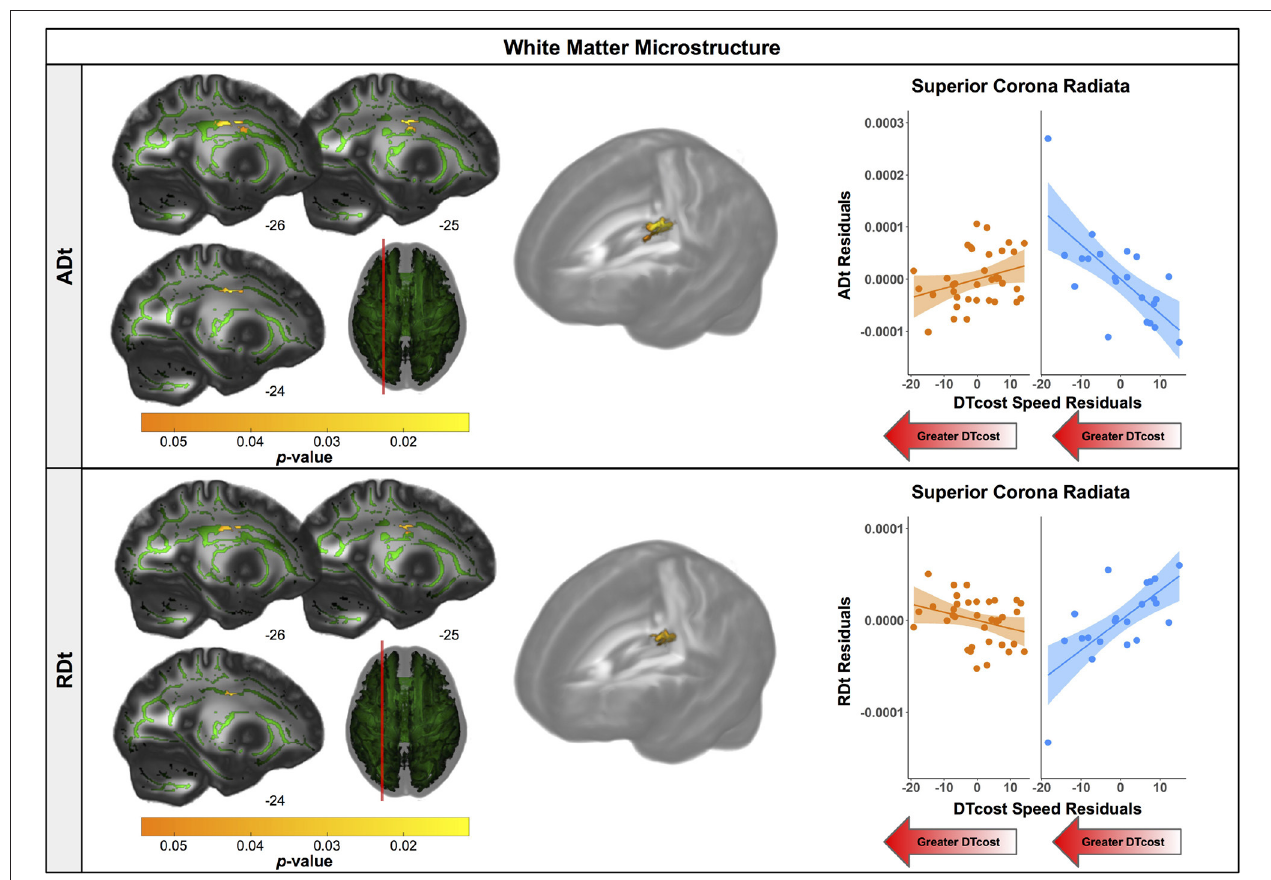
FIGURE 7 | Age differences in the relationship of FW-corrected white matter microstructure with the DTcost of gait speed. Left. Regions showing statistically significant ( p FWE − corr < 0.05) age group differences in the relationship of ADt (top) and RDt (bottom) with the DTcost of gait speed. Warmer colors indicate regions of greater age differences. Results are shown on the FMRIB58 FA template with the group mean white matter skeleton (green) overlaid. Right. ADt and RDt values for the peak result coordinate for each model are plotted against the DTcost of gait speed to illustrate examples of the relationships identified by the voxelwise statistical tests. The fit line and confidence interval shading are included only to aid visualization of these relationships. We plotted the residuals instead of the raw values here to adjust for the effects of the sex covariate included in each model.